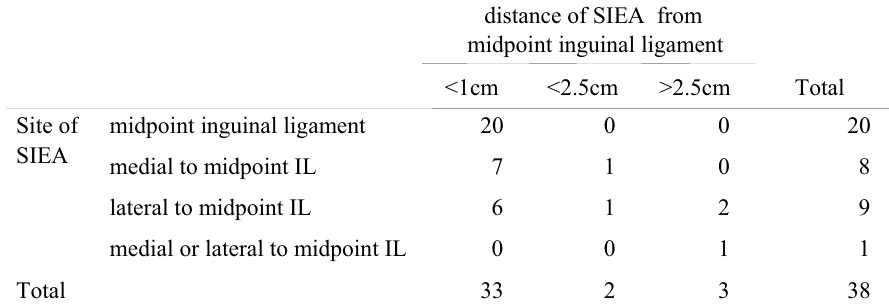
TABLE 1 - Site of identification of SIEA at inguinal